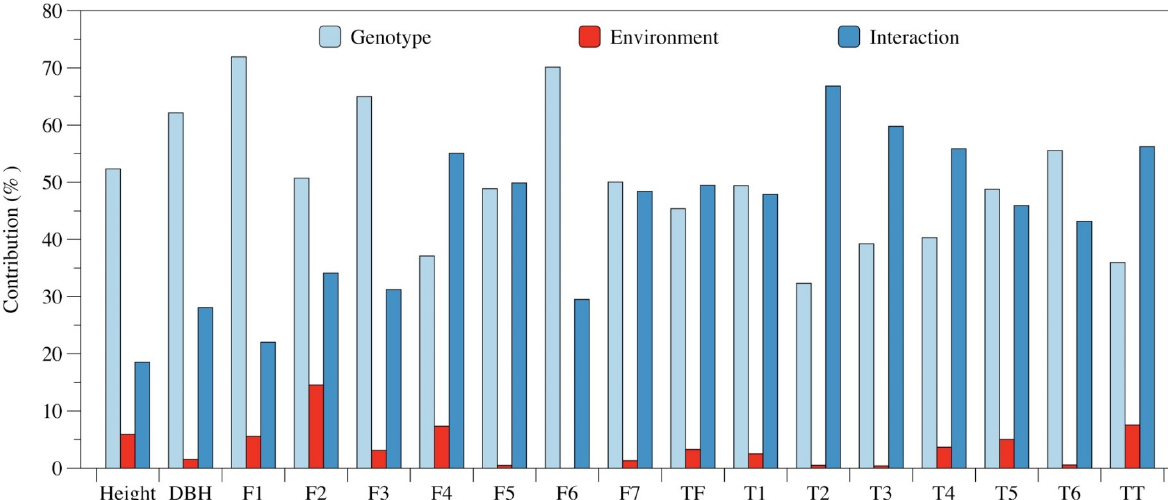
Figure 2. The percentage contributions of the genotype, environment, and their interaction effects for each trait across environments. The contribution value of each factor was the ratio of the sum of the square (SS) for each factor to the SS of the total variation from ANOVA. Height: tree height; DBH: diameter at breast height; F1: quercetin-3- O -glucuronide; F2: quercetin-3- O -galactoside; F3: isoquercitrin; F4: kaempferol-3- O -glucuronide; F5: kaempferol-3- O -glucoside; F6: quercetin-3- O -rhamnoside; F7: kaempferol-3- O -rhamnoside; TF: total flavonoid; T1: arjunolic acid; T2: cyclocaric acid B; T3: pterocaryoside B; T4: pterocaryoside A; T5: hederagenin; T6: oleanolic acid; TT: total triterpenoid.